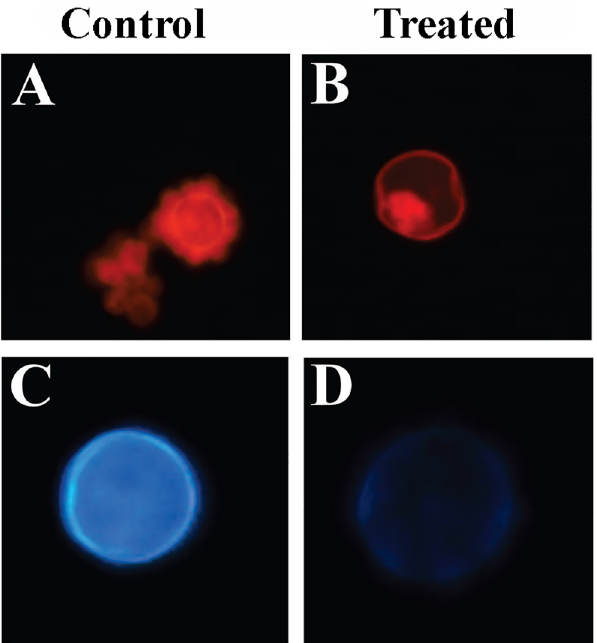
Fig 3. Effect of argentilactone on the polymer levels of the Paracoccidioides lutzii cell wall. Fluorescence microscopy showing yeast cells stained by CFW and CR: (A) P . lutzii control stained with CR; (B) P . lutzii after treatment with argentilactone, stained with CR; (C) P . lutzii control stained with CFW; (D) P . lutzii after treatment argentilactone, stained with CFW.